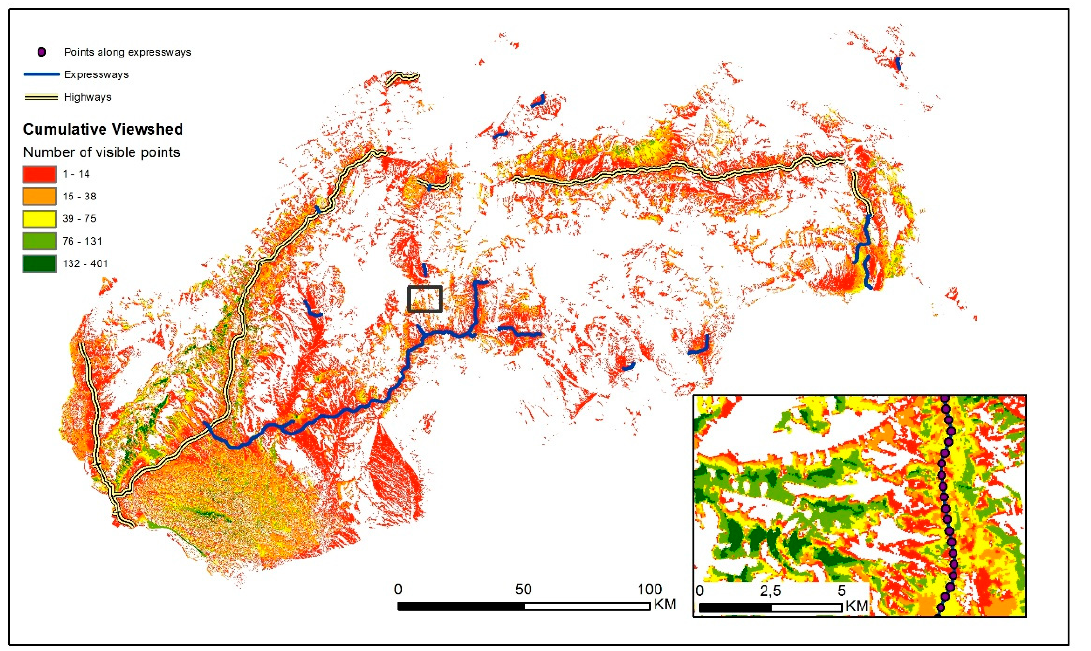
Figure 5. Cumulative viewshed from road network (classes made with natural break algorithm).